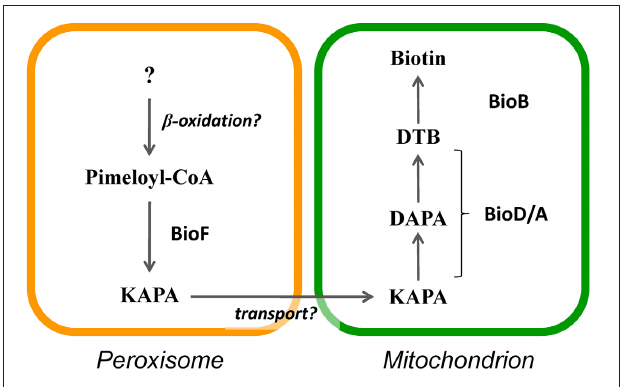
FIGURE 6 | Model of subcellular compartmentalization of the biotin biosynthetic pathway in eukaryotes.